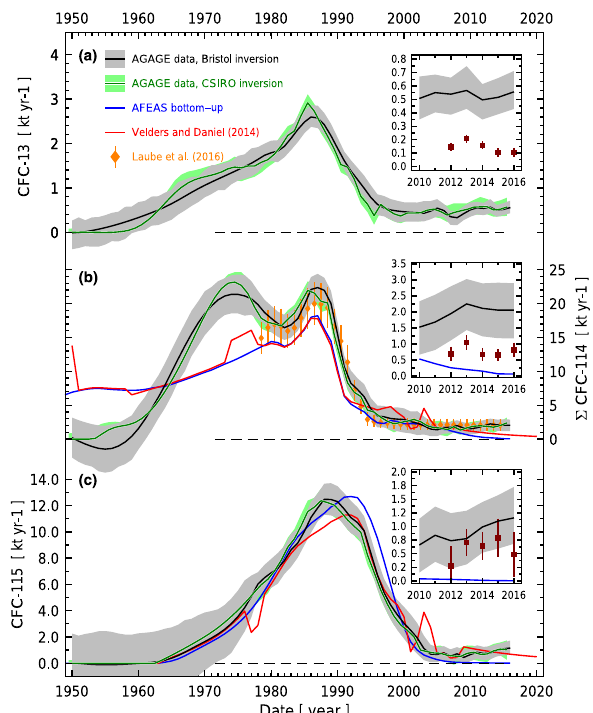
Figure 6. Global emissions of the chlorofluorocarbons CFC-13 (a) , (cid:54) CFC-114 (b) , and CFC-115 (c) from atmospheric observations. Black lines and grey shaded areas are for the Bristol inversion and green lines and green shaded areas for the CSIRO inversion (see text). Emissions from Laube et al. (2016) are the sum of the emis- sions of both C 2 Cl 2 F 4 isomers. In the insets, our observation-based global emissions and the expanded AFEAS bottom-up emissions are compared to the East Asian emissions (maroon